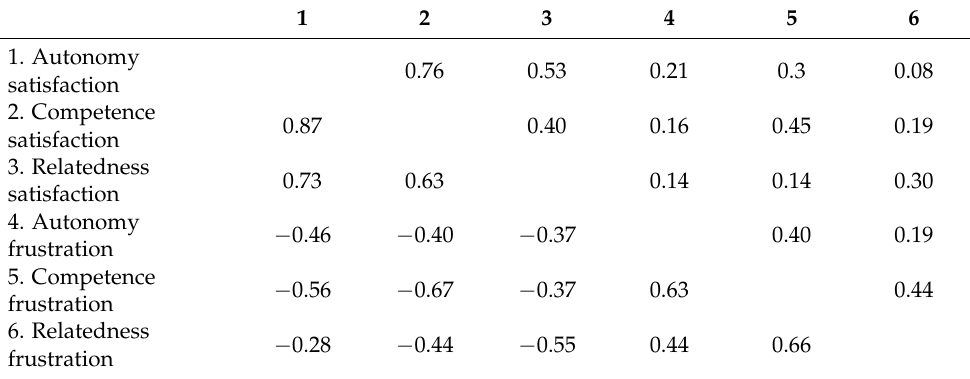
Table A4. Correlation matrix between the latent factors of the 6-factor